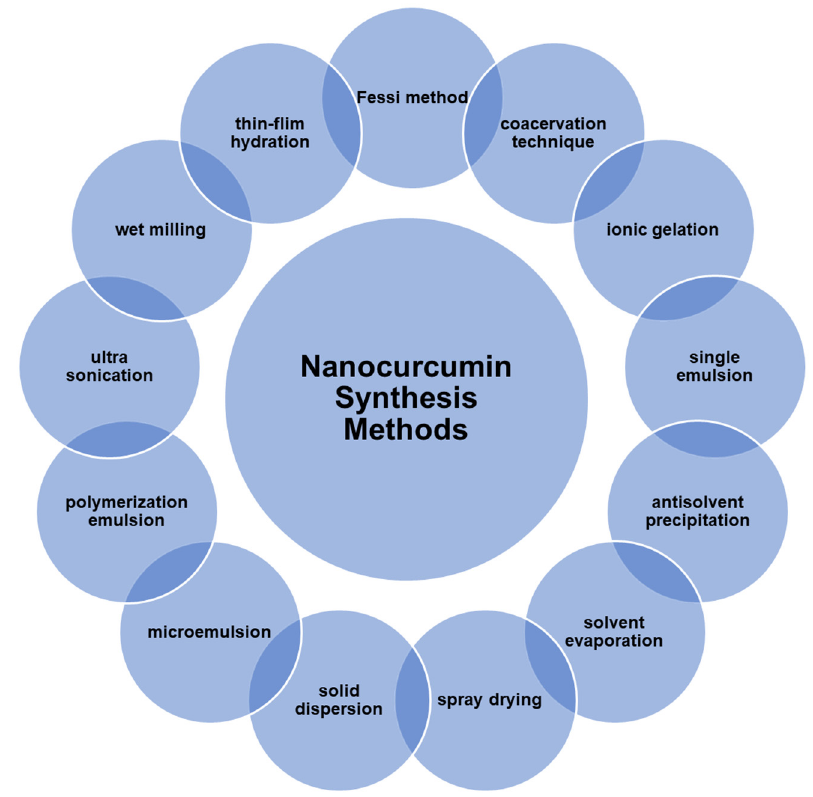
Figure 9. A summary of the methods used in nanocurcumin synthesis.